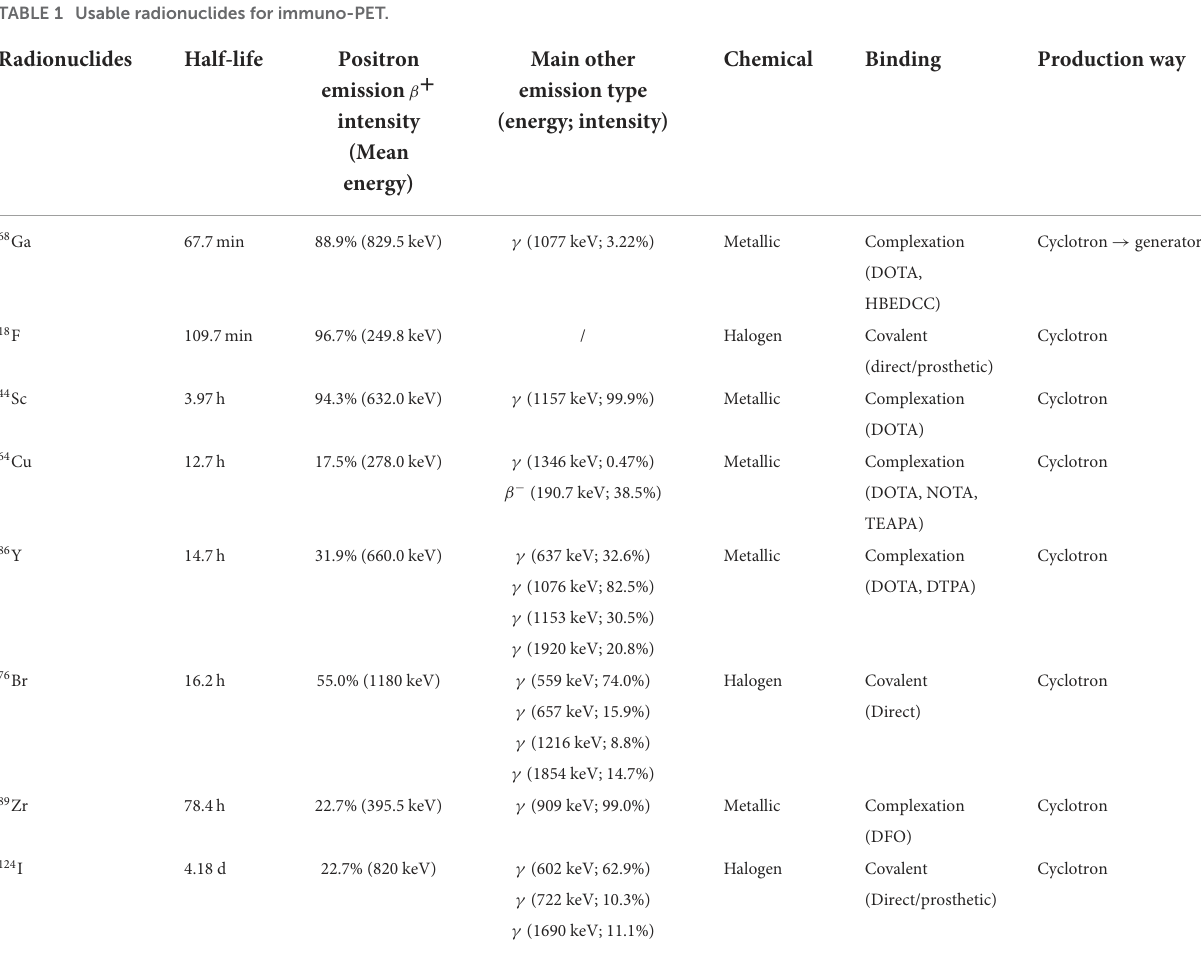
TABLE 1 Usable radionuclides for